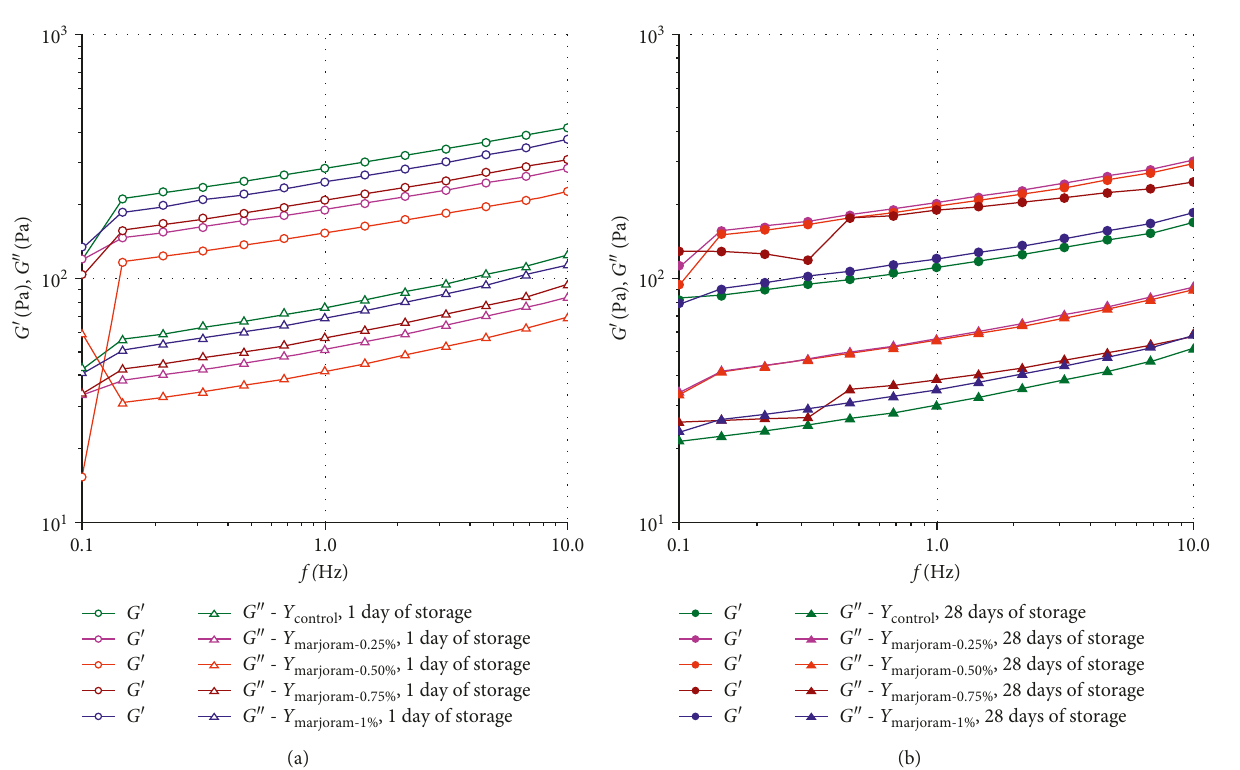
Figure 8: Viscoelastic properties of yogurt with marjoram ( Origanum vulgare L.) extract: (a) 1 day of storage; (b) after 28 days of storage.